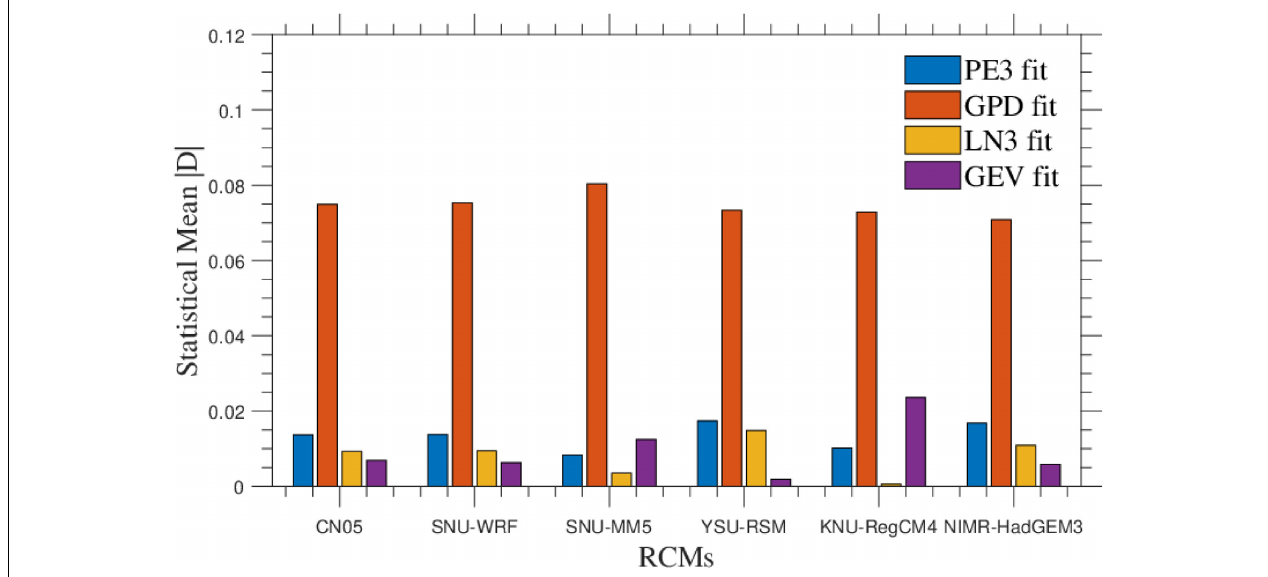
FIGURE 8 | Statistical mean values of absolute differences (|D|) of fitted L-kurtosis values from different probabilistic models against theoretical L-kurtosis values in the CN05 observational dataset and five RCM simulations (SNU-WRF, SNU-MM5, YSU-RSM, KNU-RegCM4, and NIMR-HadGEM3). Probabilistic models include the generalized extreme value (GEV) (purple bar), three-parameter lognormal (LN3) (orange bar), generalized Pareto (GPD) (red bar), and Pearson Type III (PE3) (blue bar).